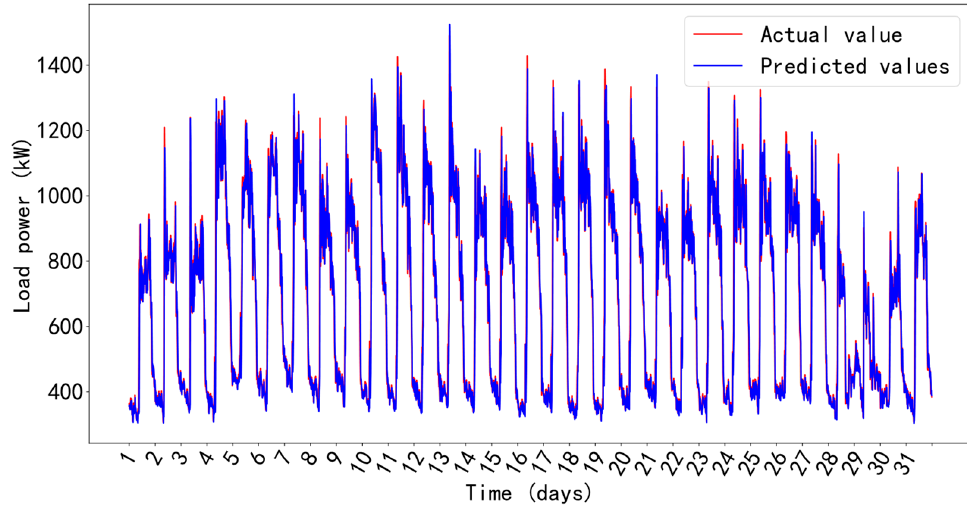
Figure 4. Monthly load forecasting results. Table 2. Comparison of training times test